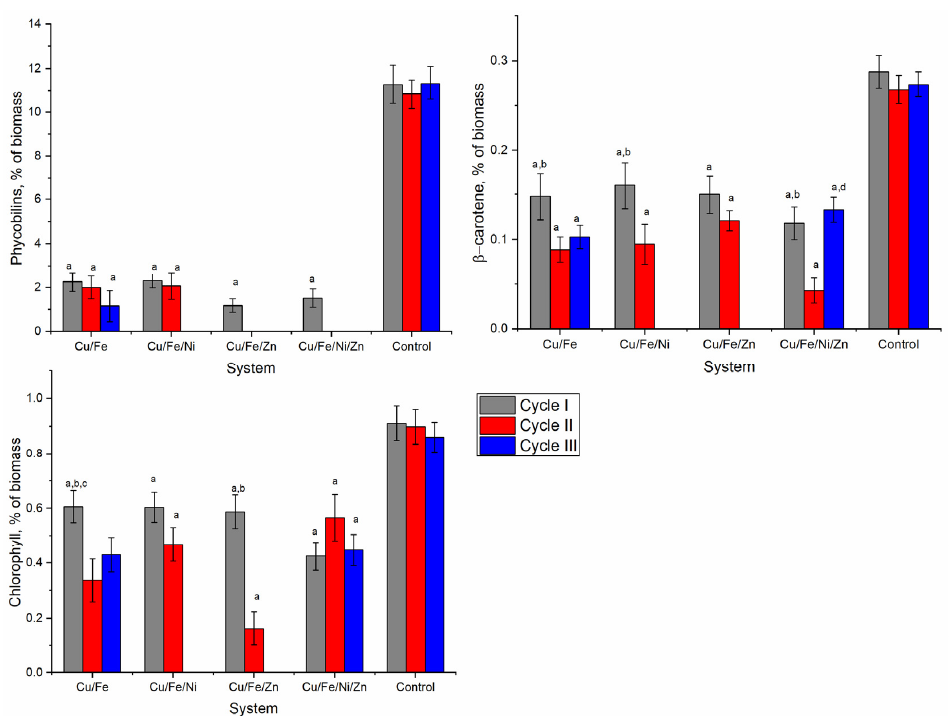
Figure 5. Total phycobiliproteins, chlorophyll α and β -carotene in Nostoc linckia biomass obtained during three cycles of cultivation in media containing multimetallic systems (a— p < 0.001 for the difference between experimental and control samples, b— p < 0.001 for the difference between the first and second cycle, c— p < 0.001 for the difference between the first and third cycles, d— p < 0.001 for the difference between the second and third cycles).